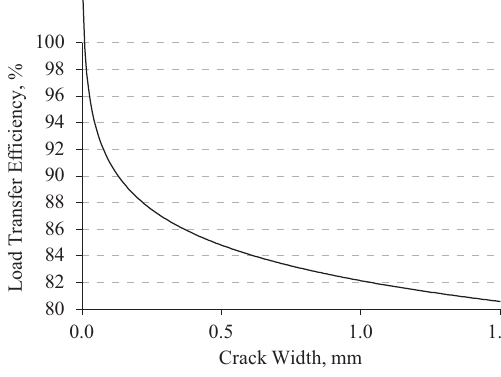
Figure 6. Design curve of Load Transfer Efficiency−Crack Width for aggregate 40